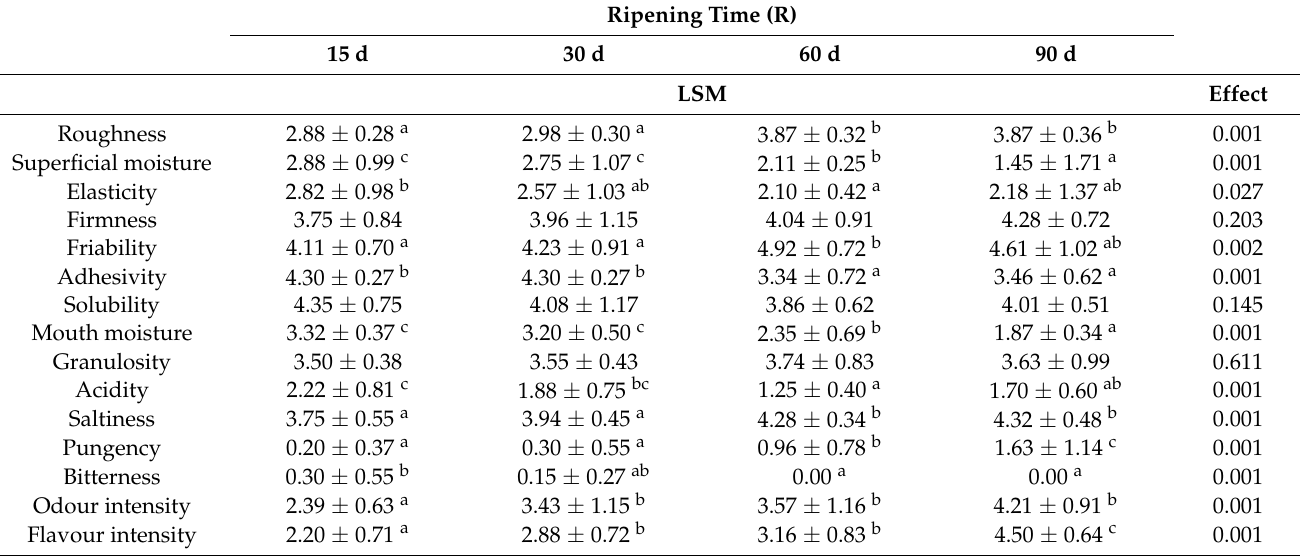
Table 2. Sensorial texture, odour and flavour characteristics of Palmero cheese.